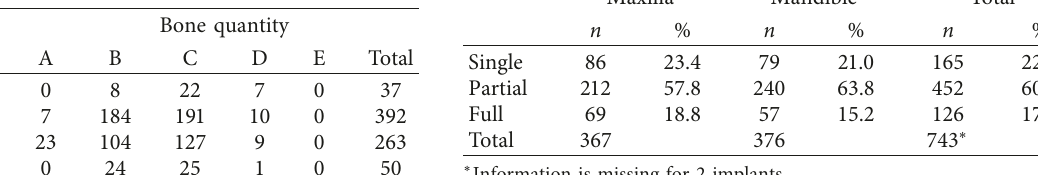
Table 3: Bone quantity and quality according to Ga and Albrektsson [20].